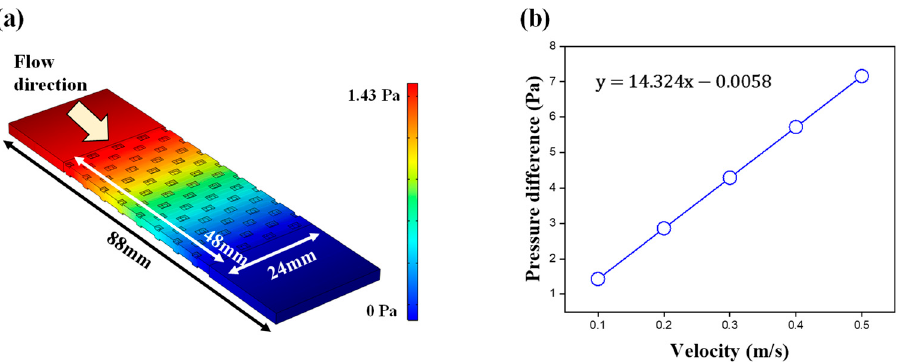
Figure 5. ( a ) Fluid simulation in corrugated plate and ( b ) pressure difference according to the velocity.